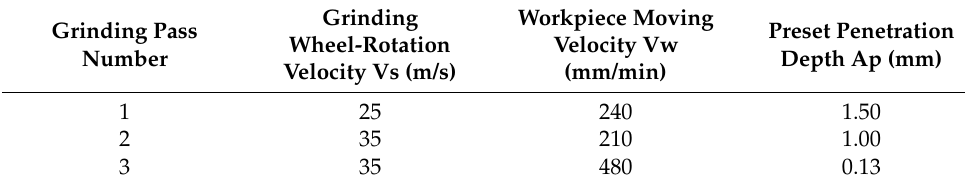
Table 2. Processing parameters during